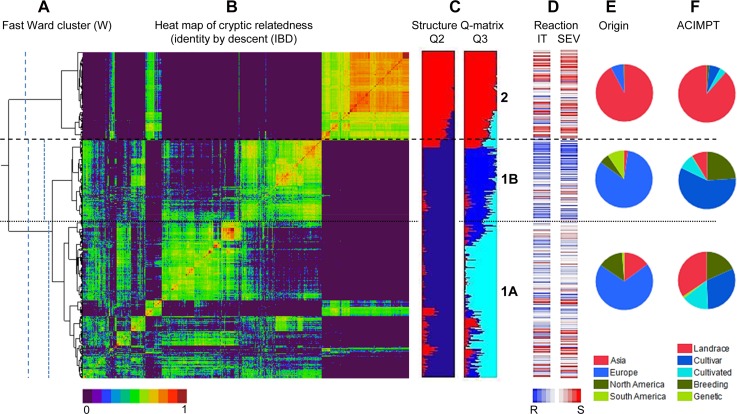
Relationship of population structure and stripe rust resistance. (A) Fast Ward clustering. Vertical dotted lines indicate genetic similarity thresholds used to classify accessions into two major groups and three subgroups. (B) Heat map of identity-by-descent (IBD) kinship matrix. The two major cluster groups and three cluster subgroups are separated by dashed and dotted lines, respectively. (C) Membership of accessions in the STRUCTURE-derived population structure subgroups. (D) Heat map of reactions of the accessions to stripe rust. IT, infection type; SEV, disease severity. Blue lines indicate resistance and red lines susceptibility based on BLUE-ALL for infection type and disease severity. (E) Frequency of population structure subgroups in geographical regions of origin. (F) Frequency of population structure subgroups in improvement status of accessions (ACIMPT).